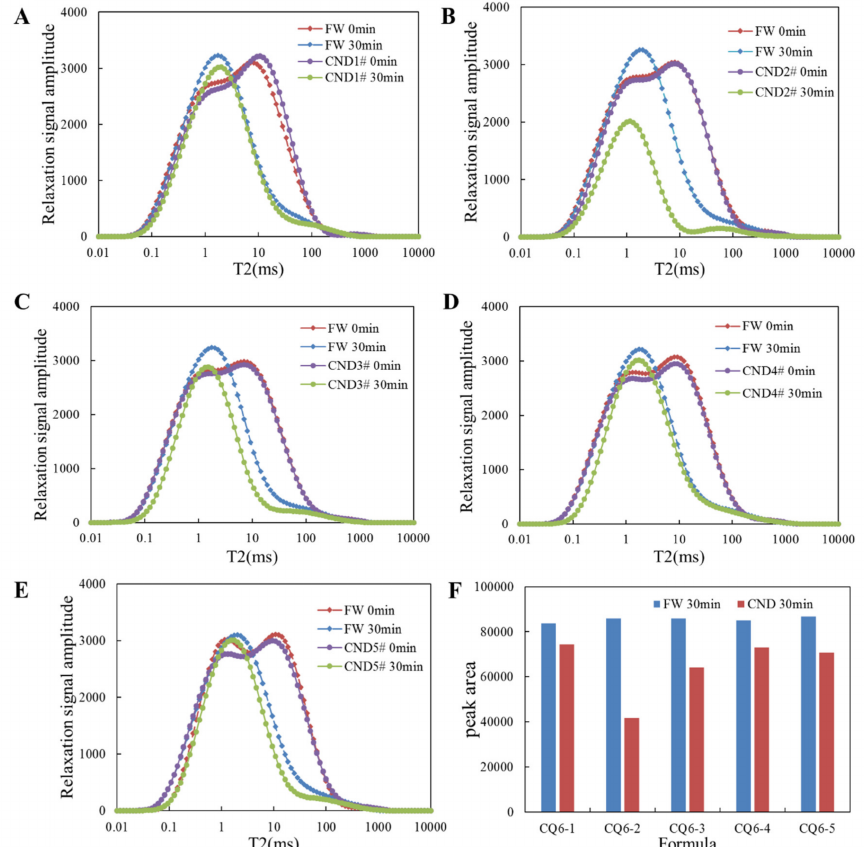
Figure 13. Curves of NMR T2 spectra and water content in cores after gas flooding with or without nanoemulsions ( A ) is the NMR T2 spectra curve of CQ6-1, ( B ) is the NMR T2 spectra curve of CQ6-2, ( C ) is the NMR T2 spectra curve of CQ6-3, ( D ) is the NMR T2 spectra curve of CQ6-4, ( E ) is the NMR T2 spectra curve of CQ6-5, ( F ) is the peak area change